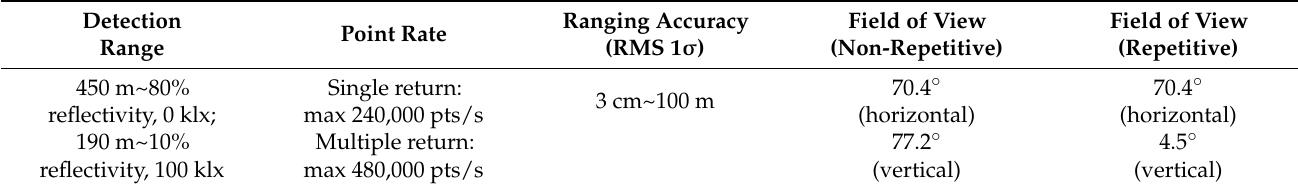
Table 1. DJI Zenmuse L1 LiDAR sensor main specifications.